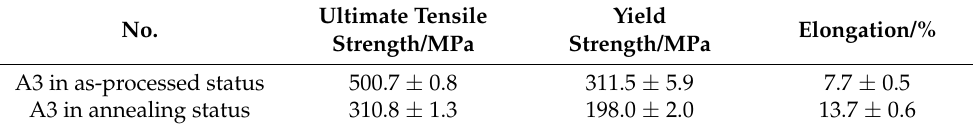
Figure 13. Three ‐ dimensional reconstruction of the A3 sample tested by CT. Table 5. Mechanical properties of A3 in annealing status and as-processed status. Table 5. Mechanical properties of A3 in annealing status and as ‐ processed status.